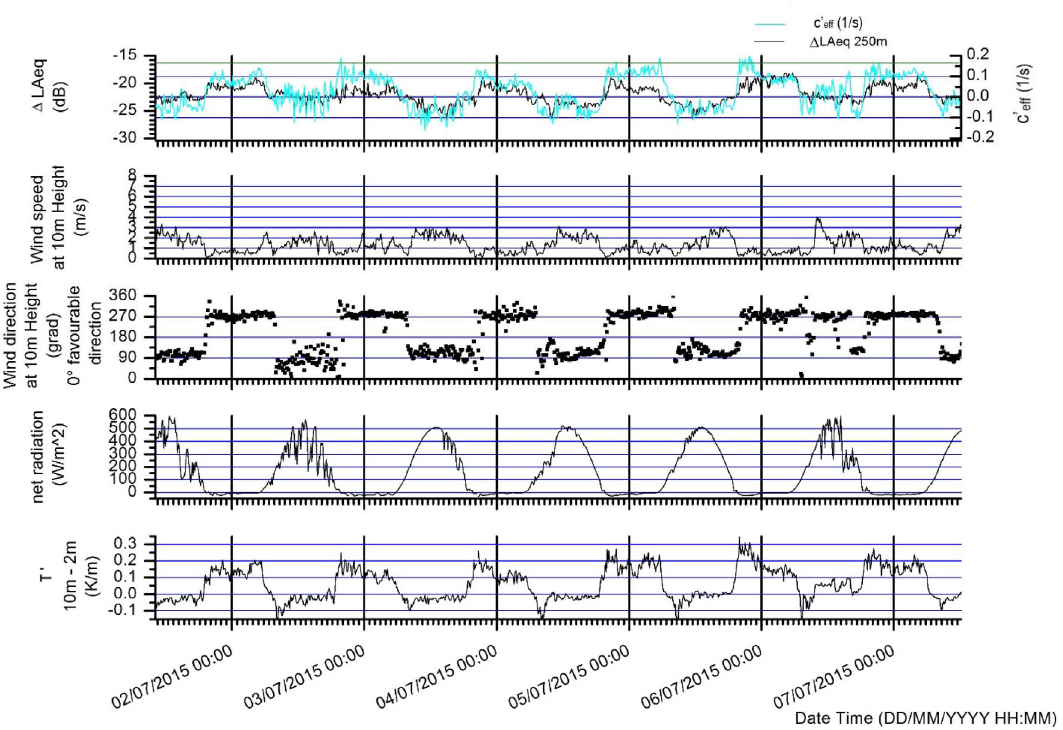
Figure 2. Markt Allhau: Sound level difference 4 L Aeq, 250m and effective sound speed gradient with meteorological data wind speed, wind direction (0 (cid:3) correspond downwind sound propagation), net radiation and temperature gradient (10 m – 2 m) measured in K/m.